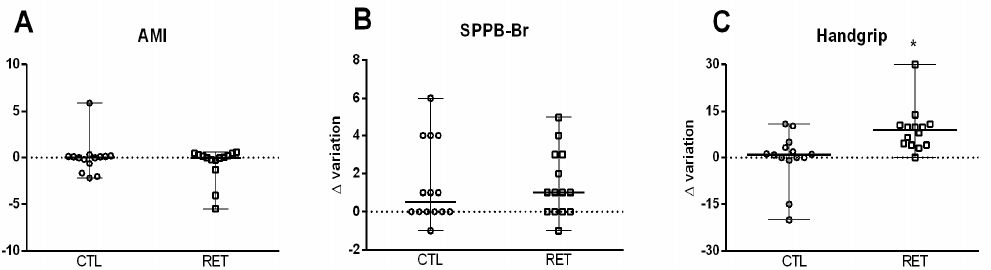
Figure 3. Sarcopenia criteria analyses. ( A )—AMI: Delta variation appendicular muscle index. ( B )—Delta variation handgrip strength values. ( C )—Delta variation SPPB: Short Physical Performance Battery values. CTL: control; RET: resistance exercise training. * Different from CTL, p < 0.05.